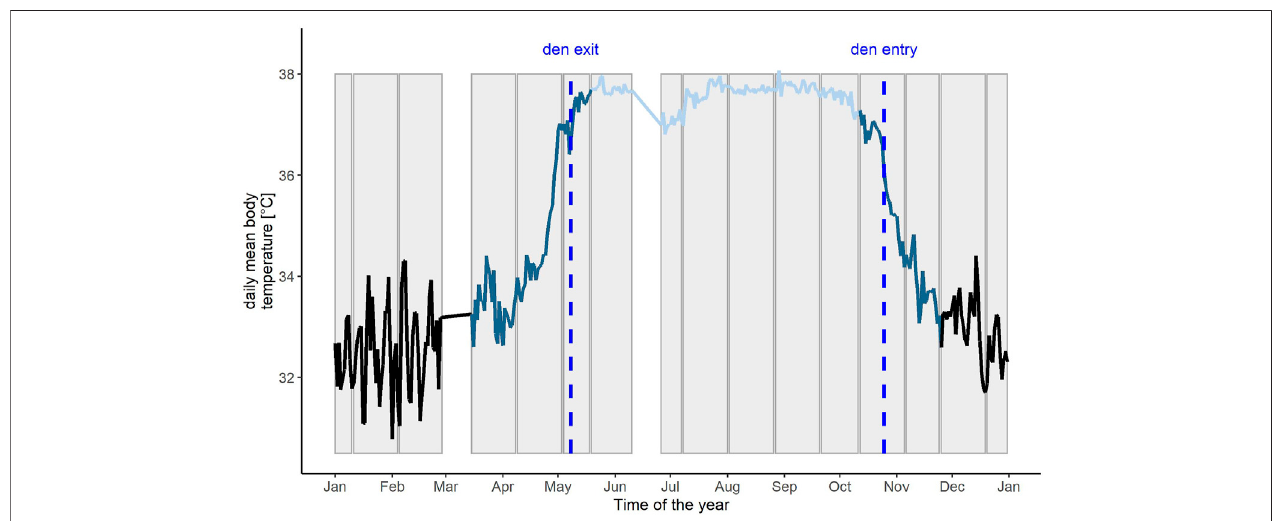
FIGURE1| Exampleofthedailymeanbodytemperaturepro fi leofaScandinavianbrownbearfromJanuary-Decemberwiththedifferenttimeperiodsindicatedas hibernation (black), transition (dark blue) and active phase (light blue). Den entry and den exit are shown as black dotted lines. The 15-25 days intervals, the biological rhythms analysis is based on, are indicated as grey bars in the background. White blocks represent data gaps due to capture events.